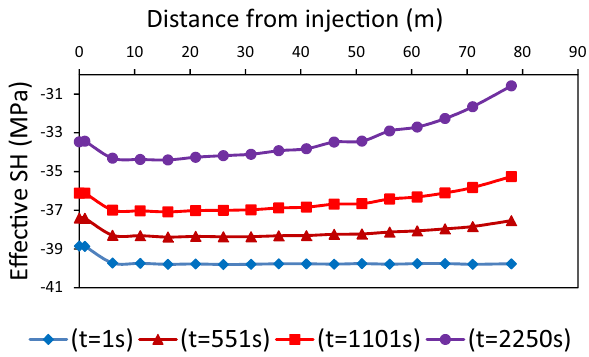
Fig. 11 Case 2 ( k = 45.9 mD): Effective maximum horizontal stress versus distance along SRV length from the injection port at different injection